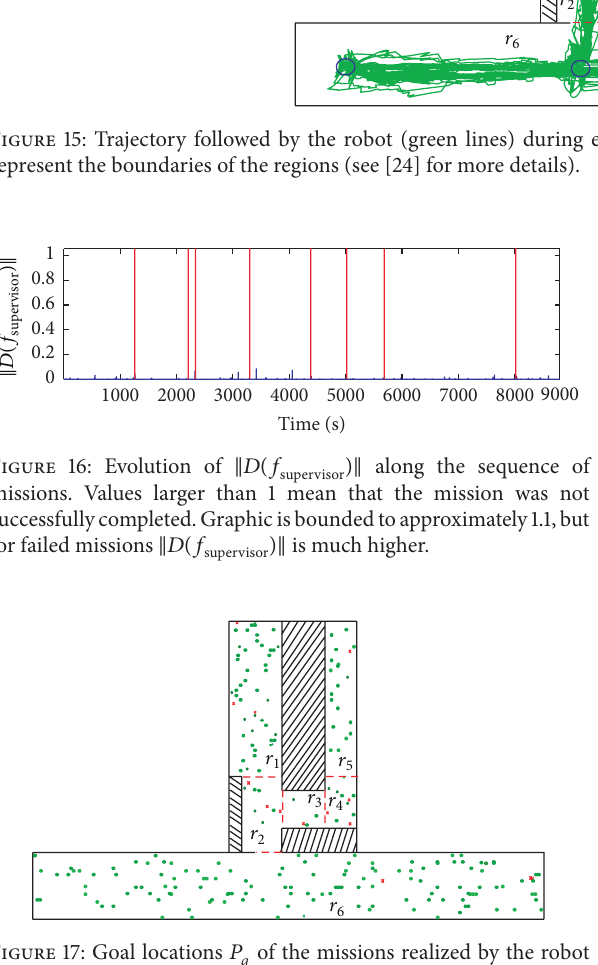
Figure 17: Goal locations 𝑃 𝑔 of the missions realized by the robot during experiment 4. Green circles represent successful missions whereas red crosses represent unsuccessful missions. There are a total number of 230 successful missions and 12 unsuccessful missions.